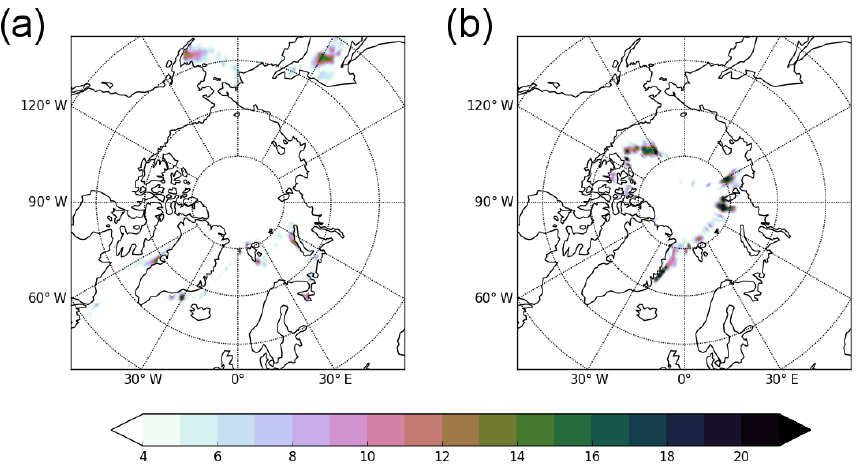
Figure 24. Ensemble spread of ORAS5 SIC (in percent) in (a) March and (b) September. Ensemble spread is estimated as the standard deviation of its five ensemble members, computed using monthly mean SIC in